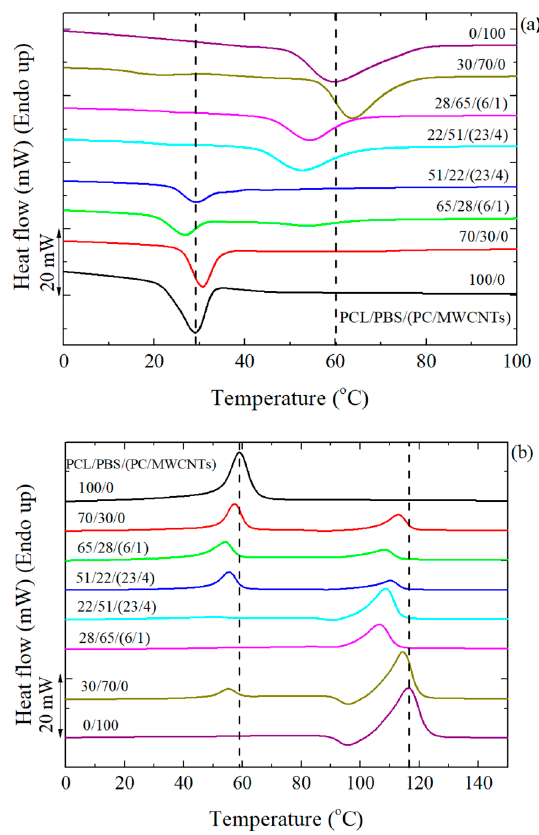
Figure 3. ( a ) Cooling and ( b ) second heating curves for the PCL/PBS blends and their nanocomposites.